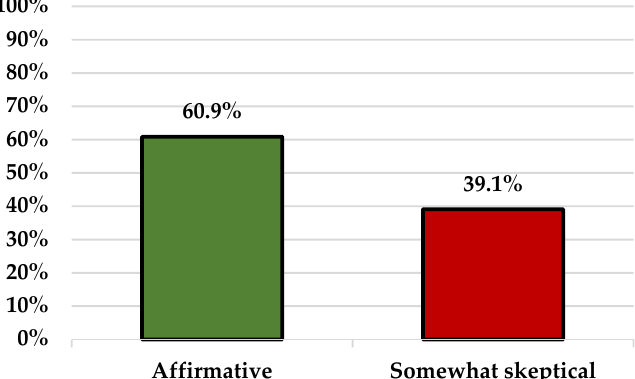
Figure 3. COVID-19 Figure 3. COVID-19 vaccination .